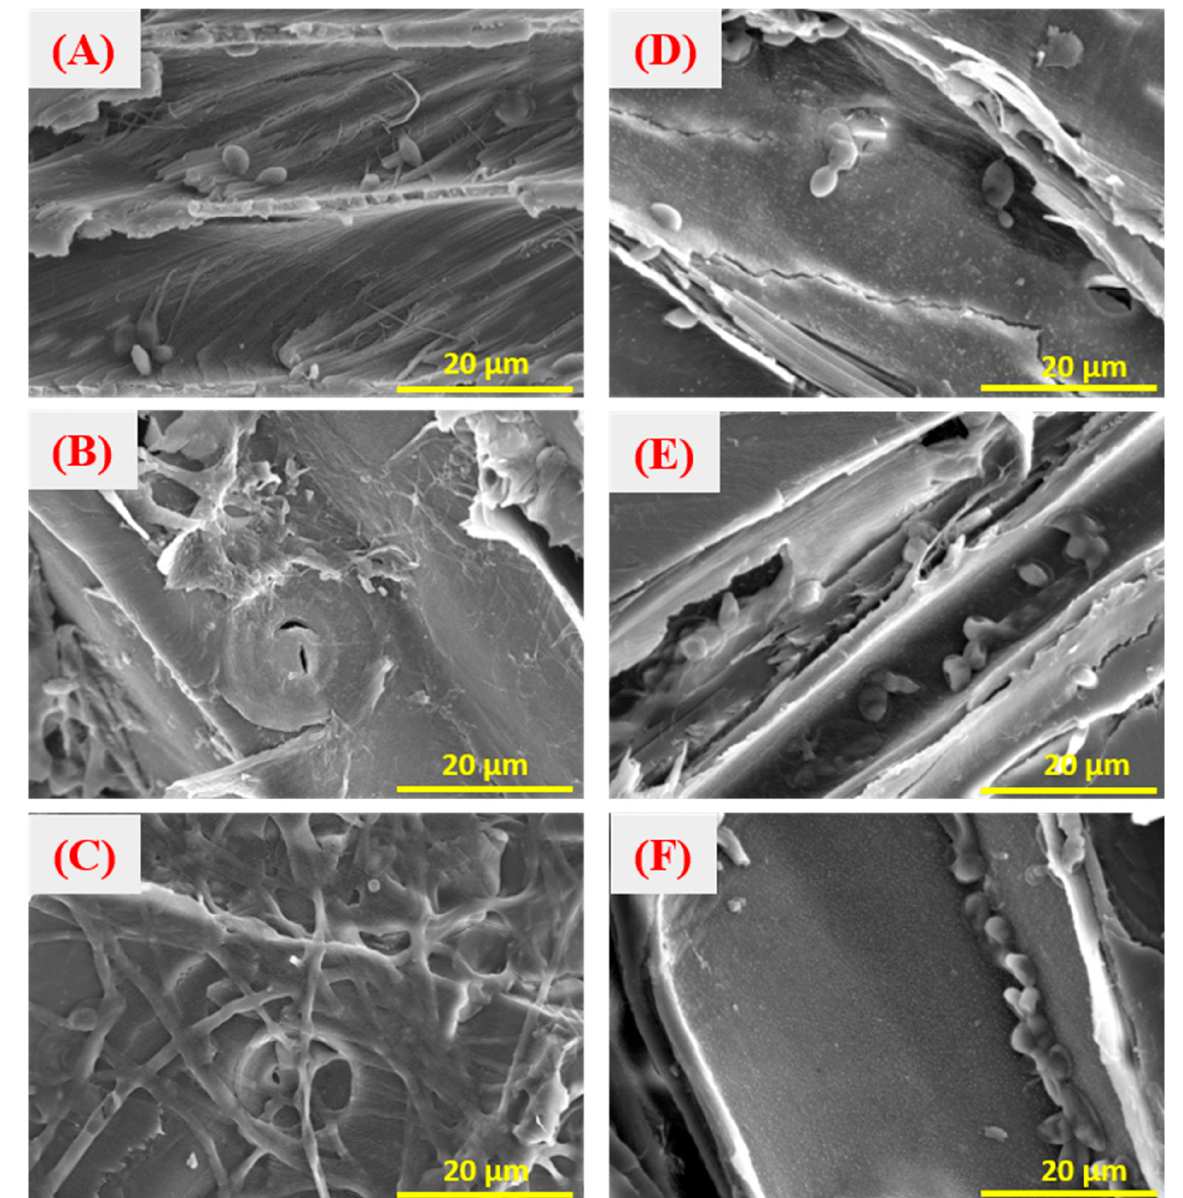
Figure 2. Micro-morphology of CCA-treated wood treated with the Y. lipolytica : CCA wood treated with OD 600nm = 0.05 for 1d ( A ), 9d ( B ), and 21d ( C ), and CCA wood treated with domesticated strains of sample B for 1d ( D ), 9d ( E ), and 21d ( F ).